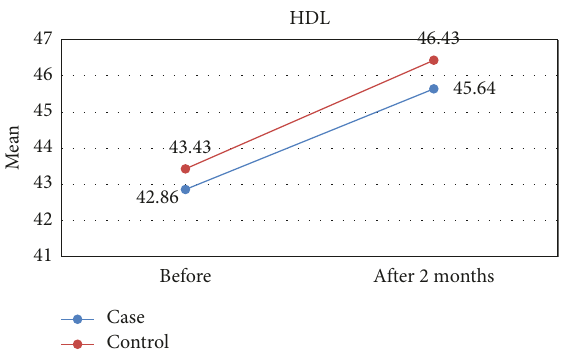
Figure 6: Effect of lycopene supplementation on HDL-C levels.